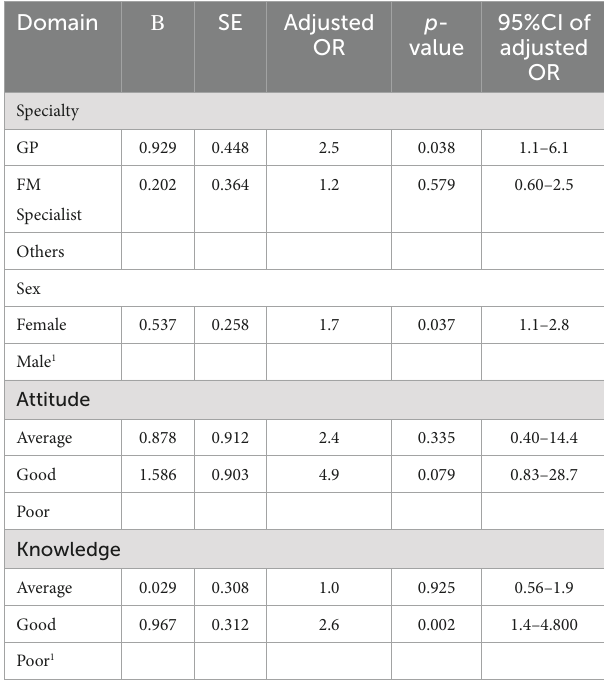
TABLE 6 Factors significantly associated with Physicians’ favorable